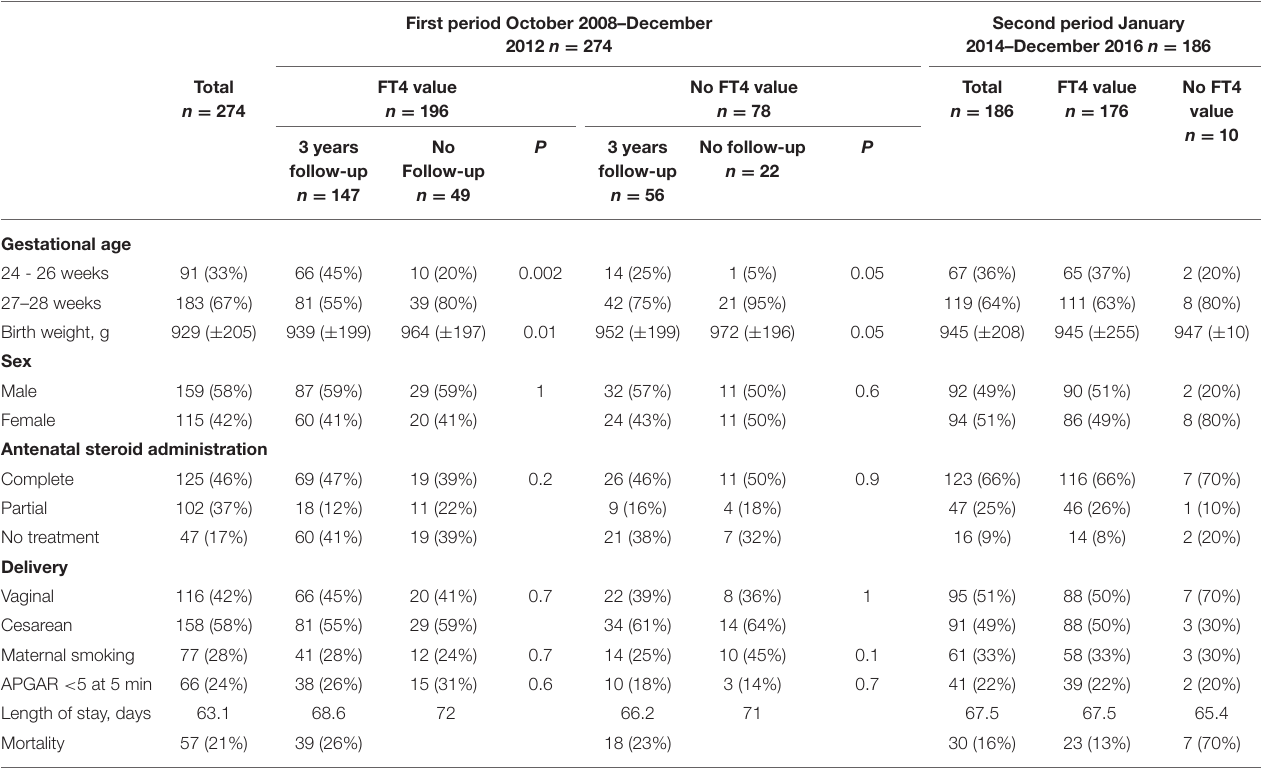
TABLE 1 | Demographic and perinatal characteristics of infants born in the two time